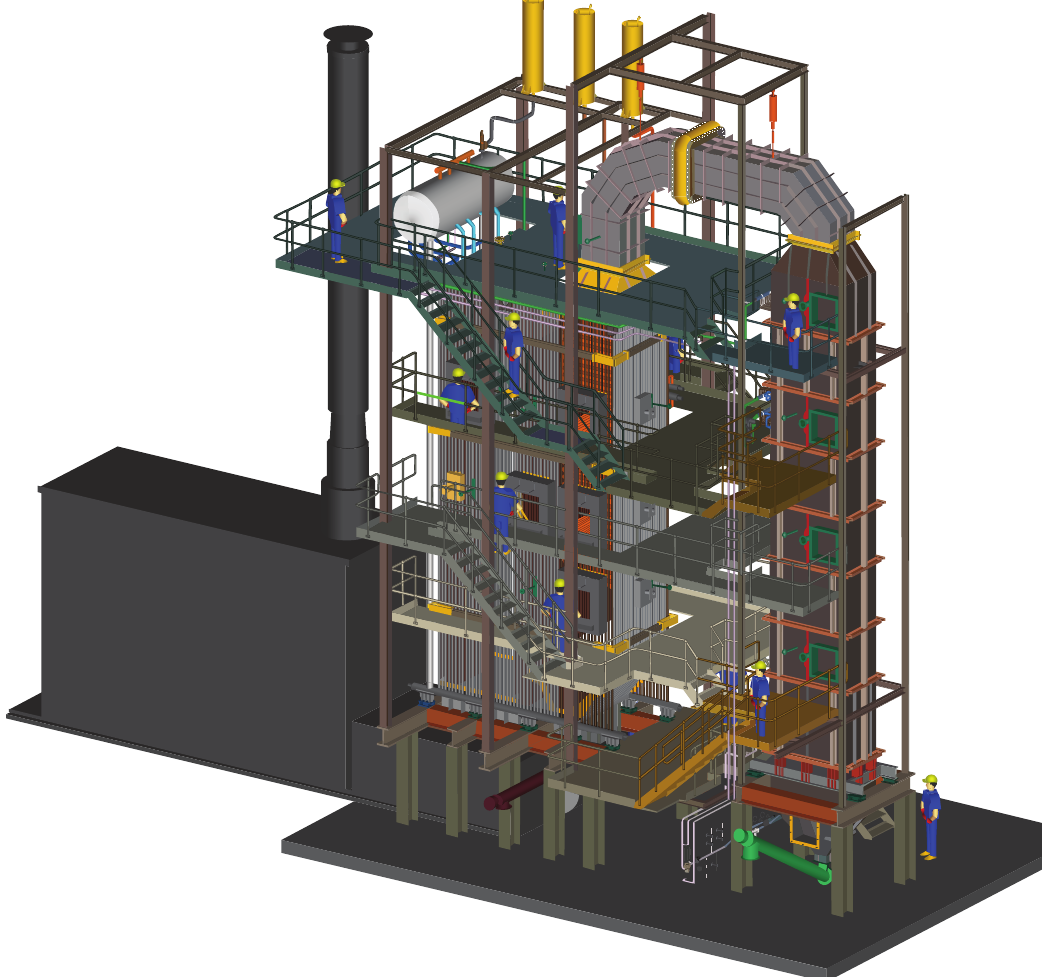
Figure 6: 3D-disposition of biomass incineration power plant